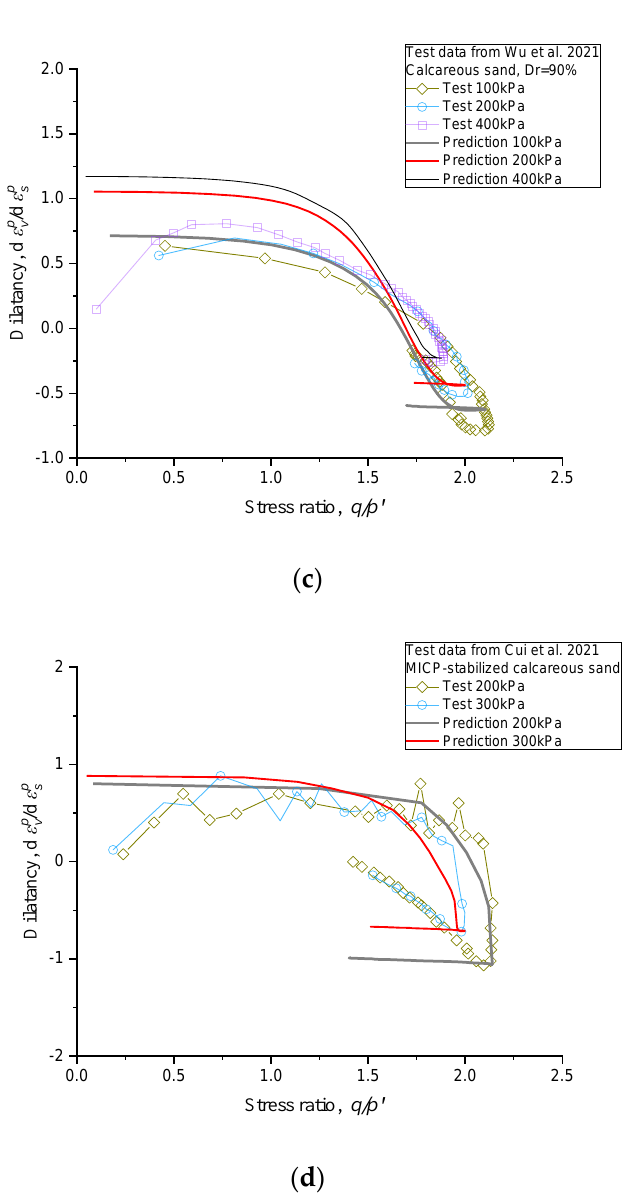
Figure 16. Predictions of the turning hooks of the stress − dilatancy curves: ( a ) calcareous sand ( Zhang & Luo 2021 [5]) , ( b )calcareous sand ( Cui et al., 2021 [4]) , ( c ) calcareous sand ( Wu et al., 2021 [1]), and ( d ) MICP-stabilized calcareous sand ( Cui et al., 2021 [4]) .